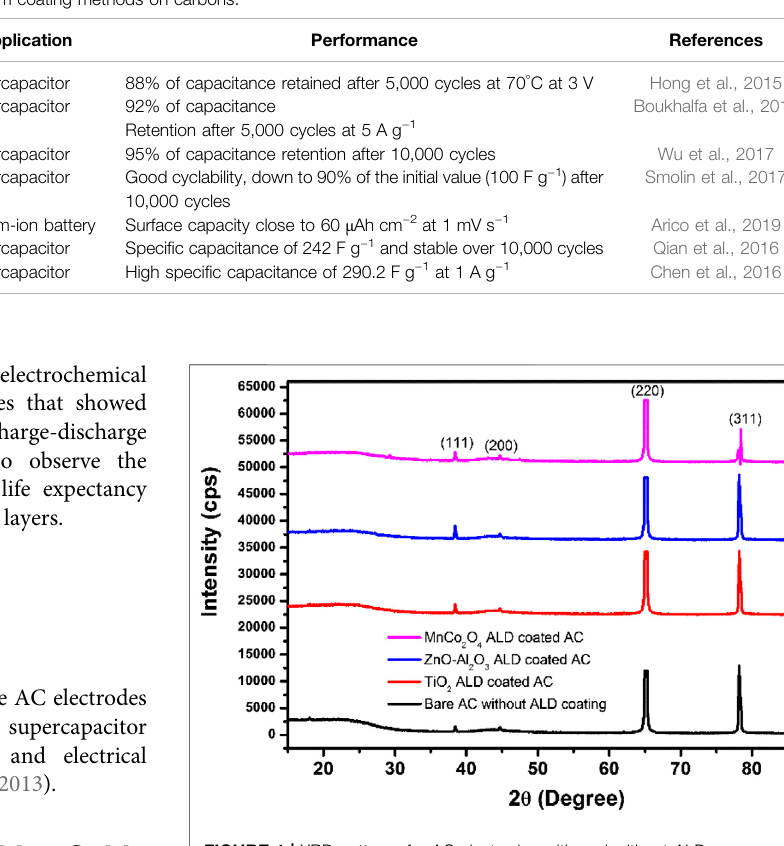
FIGURE 1 | XRD patterns for AC electrodes with and without ALD coating ofMnCo 2 O 4 ,ZnO-Al 2 O 3 , and TiO 2 .The four major peaks are from the Al